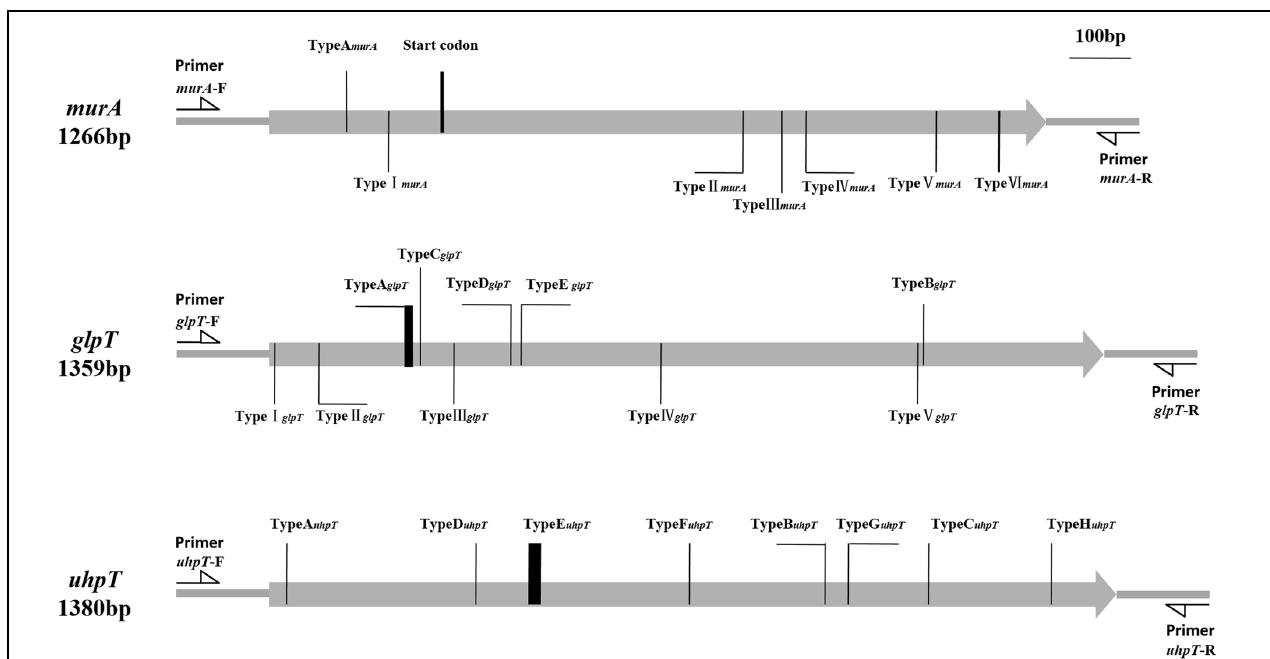
FIGURE 1 | Types and positions of mutation in murA , glpT, and uhpT genes. TypeA murA (KT372186): T125A (Result in a possible start codon in position 94th aa); TypeI